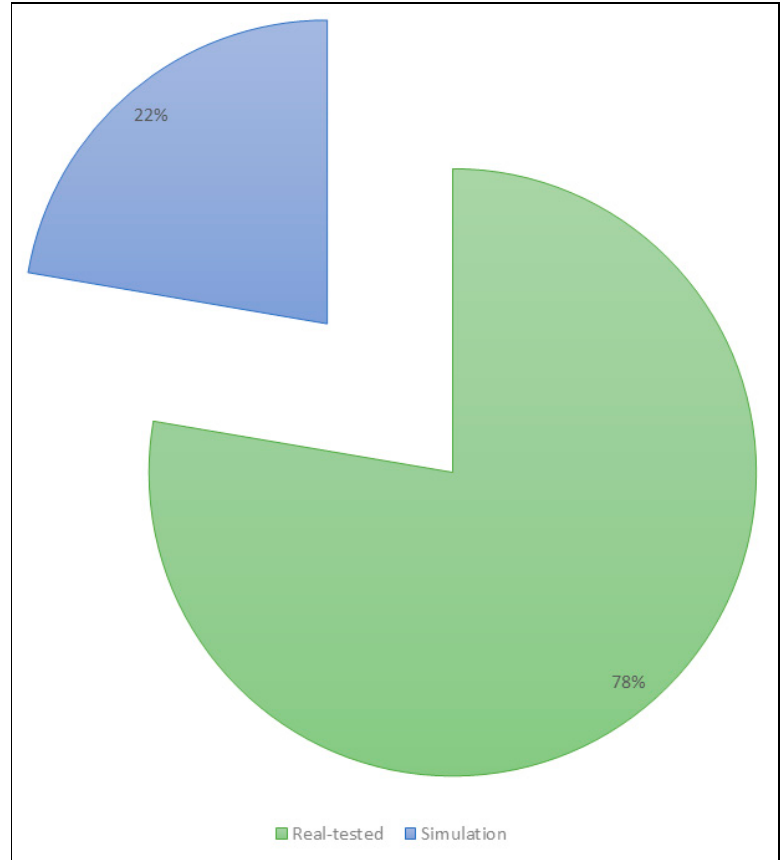
Figure 7. The percentage of evaluation techniques in all investigations. RQ3: What opportunities are available with the existing IoT techniques in clinical laboratory systems?